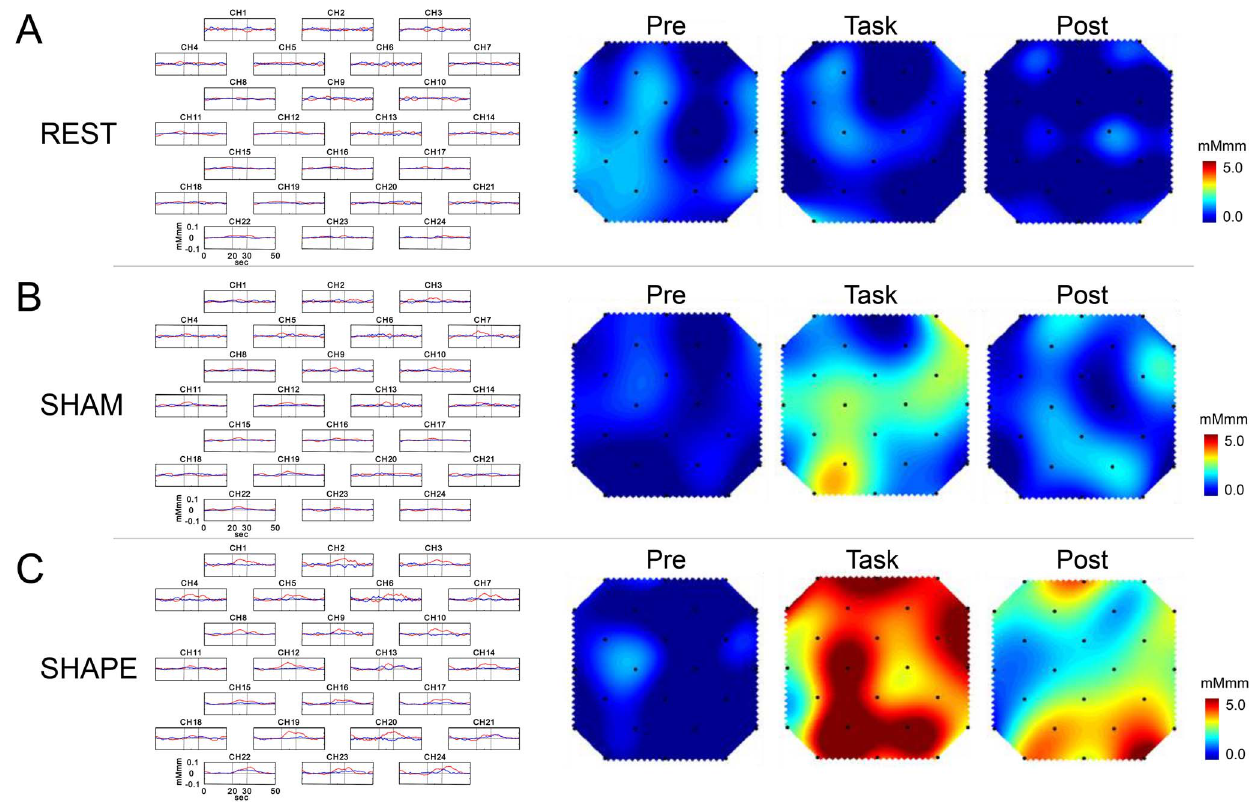
Figure 3. Grand average waveforms and topographical maps. Left: Grand average change in oxygenated-hemoglobin concentration ([oxy- Hb], red line) and deoxygenated-hemoglobin concentration ([deoxy-Hb], blue line) during (A) REST, (B) SHAM, and (C) SHAPE) sessions for each of the 24 measurement channels. The x-axis indicates time (s) and y-axis indicates hemodynamic change (mMmm). Grey vertical lines at 20 and 30 seconds indicate the start and end of the 10-second task period. Right: Topographical maps for changes in [oxy-Hb] in the 10-second period preceding the task period (Pre), the 10-second task period (Task), and the 10 seconds following the task period (Post) during the (A) REST, (B) SHAM, and (C) SHAPE sessions. There was no change in [oxy-Hb] throughout the REST session (A), while there was a slight increase during the task period in the SHAM session (B), and a marked increase during and following the task period in the SHAPE session (C).